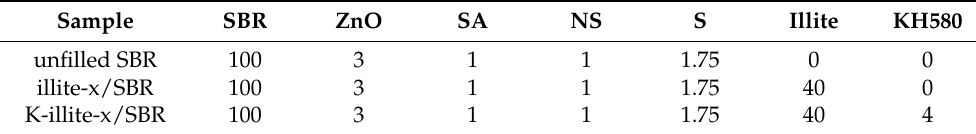
Table 1. The basic formulation (per hundred parts of rubber,